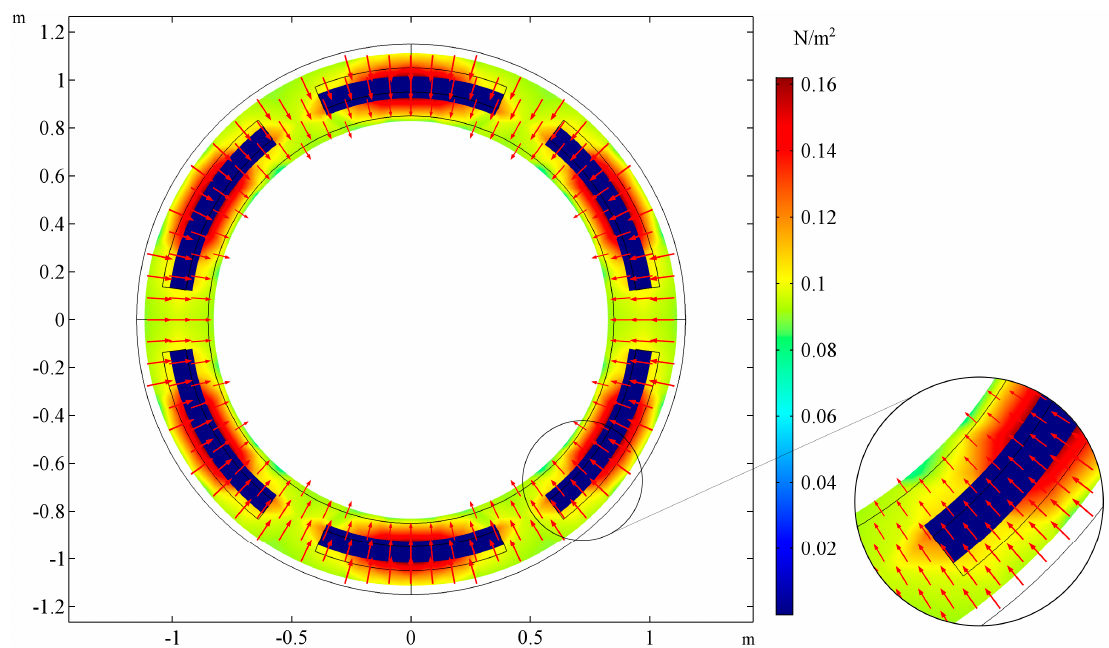
Figure 6. The deformation of the cross-section of the tube stretched and stress field for E R /E M = 0.001, the auxeticity of the reinforcement’s structure is dominated by the behavior of the matrix material. The reinforcement embedded in the matrix material: t h = 0.2. The area of stress concentration is magnified on the right.